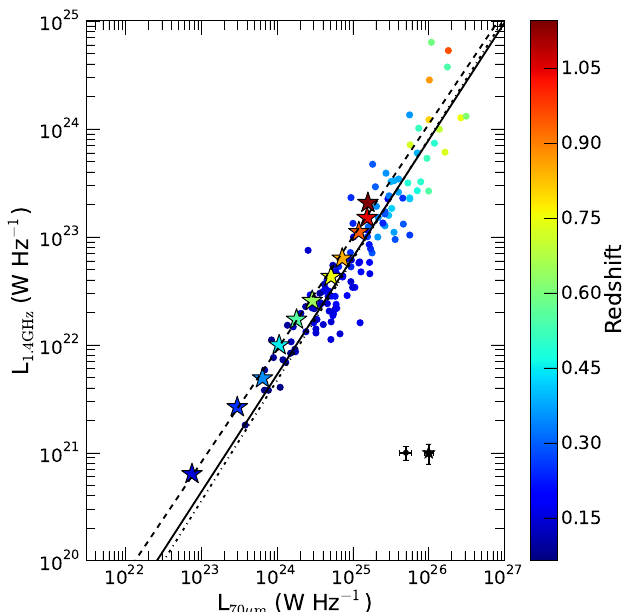
Figure 3. Radio luminosity at 1.4 GHz against monochromatic infrared luminosity at 70 µ m at rest frames. Sources detected in the XMM-LSSfield are shown as circles; stacked sources as stars. The symbols are colour-coded based on their redshift. The solid line shows the fit to the entire data, and the dashed and dashed–dotted lines are for the stacked and detected sources, respectively (from